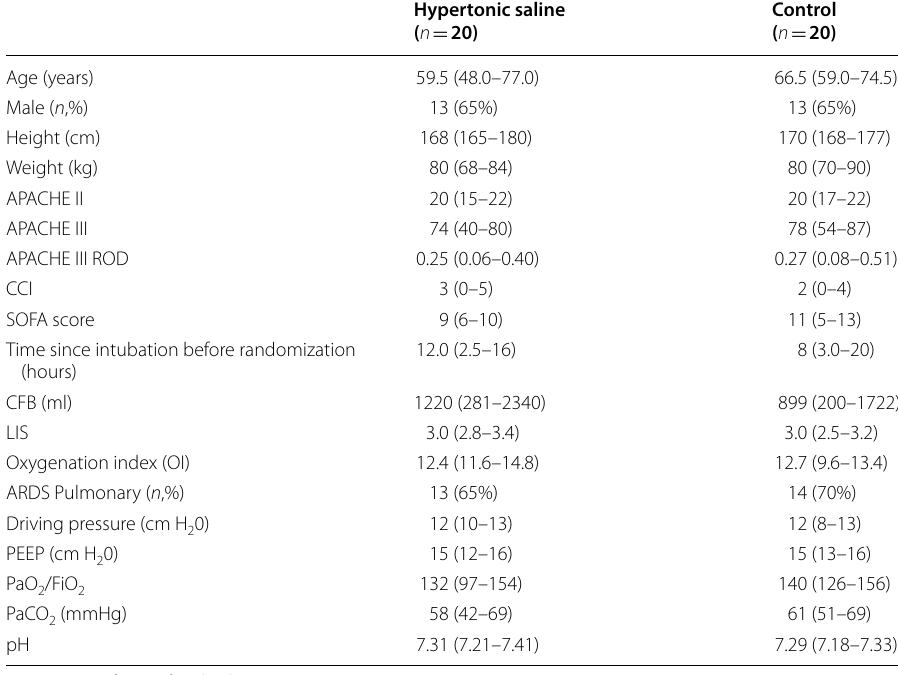
Table 1 Baseline characteristics of patients included in the